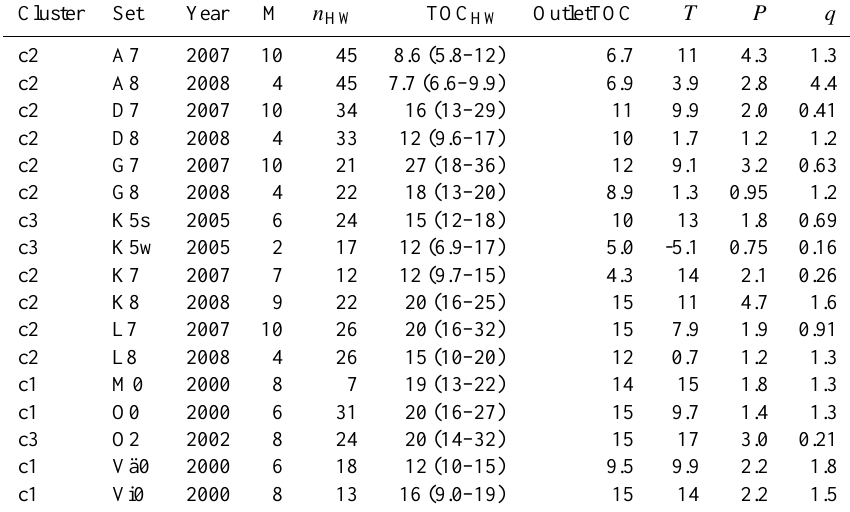
Table 2. Median concentration of total organic carbon (TOC, mgL − 1 ) , with 25th and 75th percentiles in brackets, plus weather parameters ( T , P , q ) using the median value from the 30days prior to sampling as modelled by SMHI (See Methods for more details). Clusters are the different groups of calibration and test sets used in the modelling. Sets are the different data sets used, with acronyms corresponding to river names (Table 1) and the last digit of the sampling year. M = Month of sampling, HW is headwaters and n HW = number of sampled